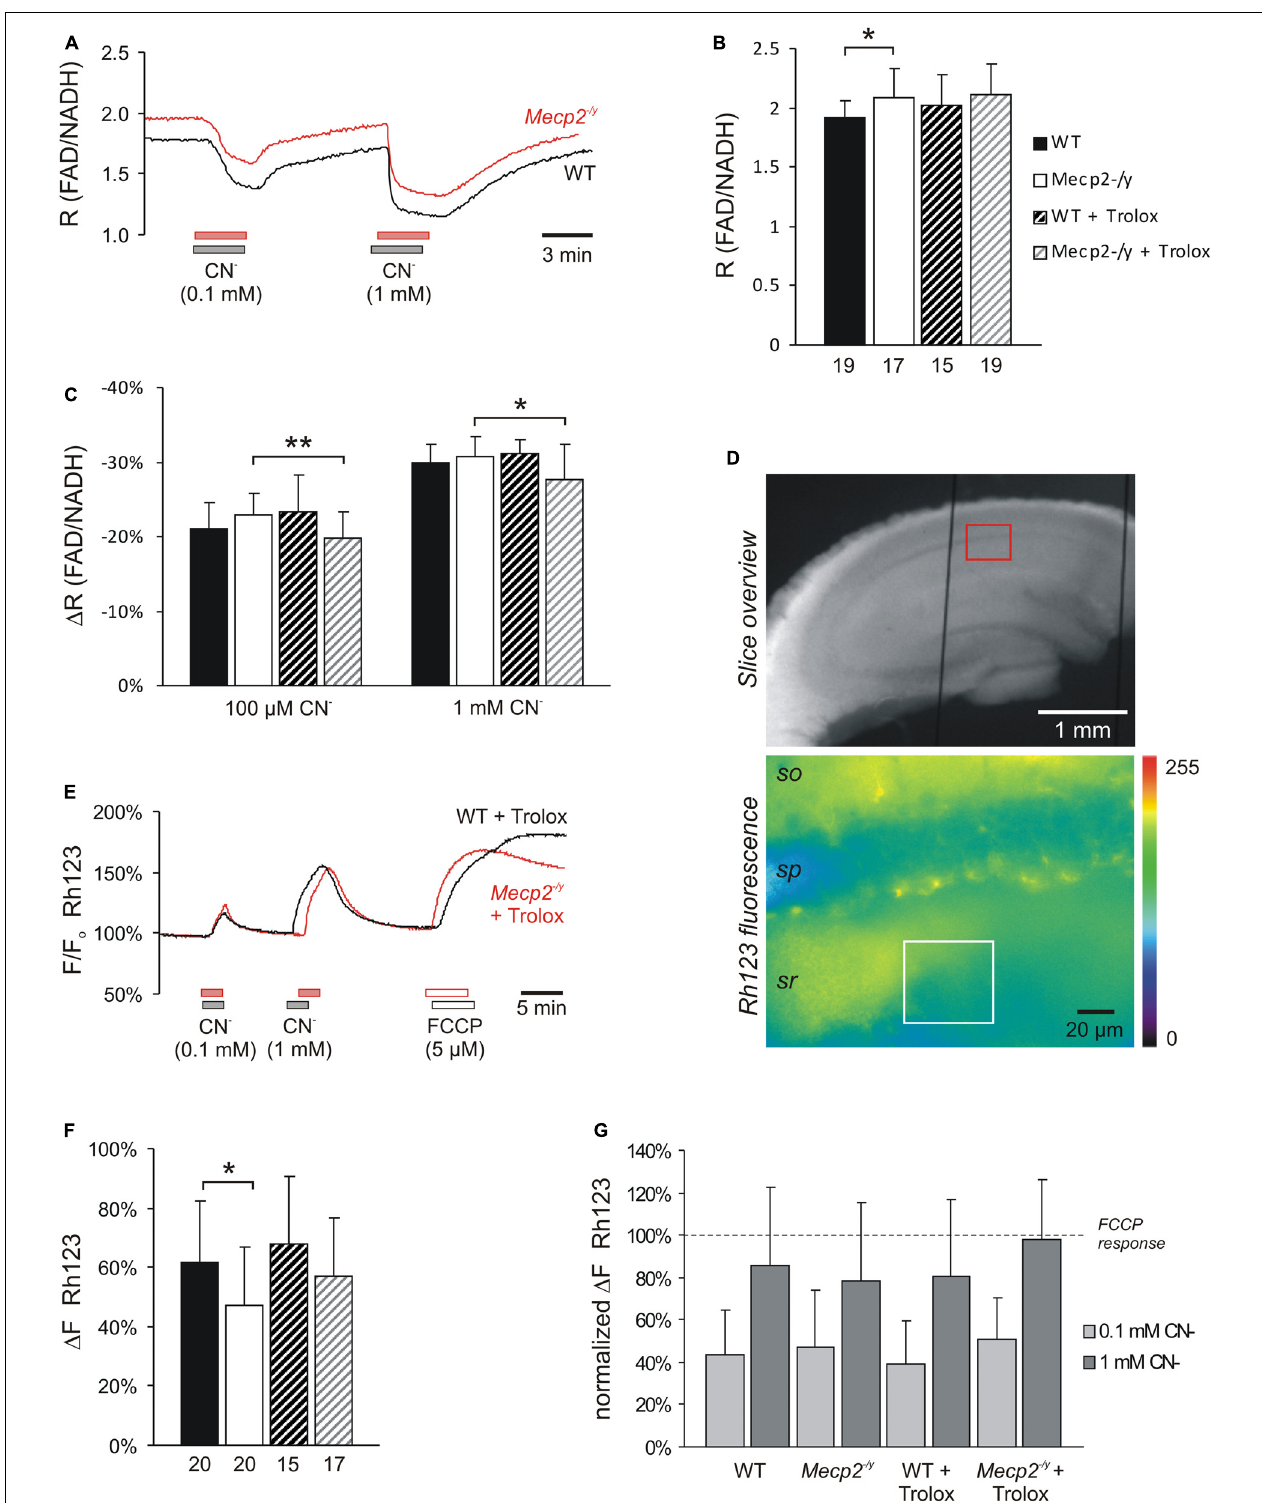
FIGURE 4 |Trolox only slightly affects mitochondria . (A) Sample traces of the decreases in FAD/NADH ratio induced by CN − in untreatedWT and Mecp2 − / y slices.To clarify the baseline difference among genotypes, the traces were superimposed. Gray and red bars indicate the time points and